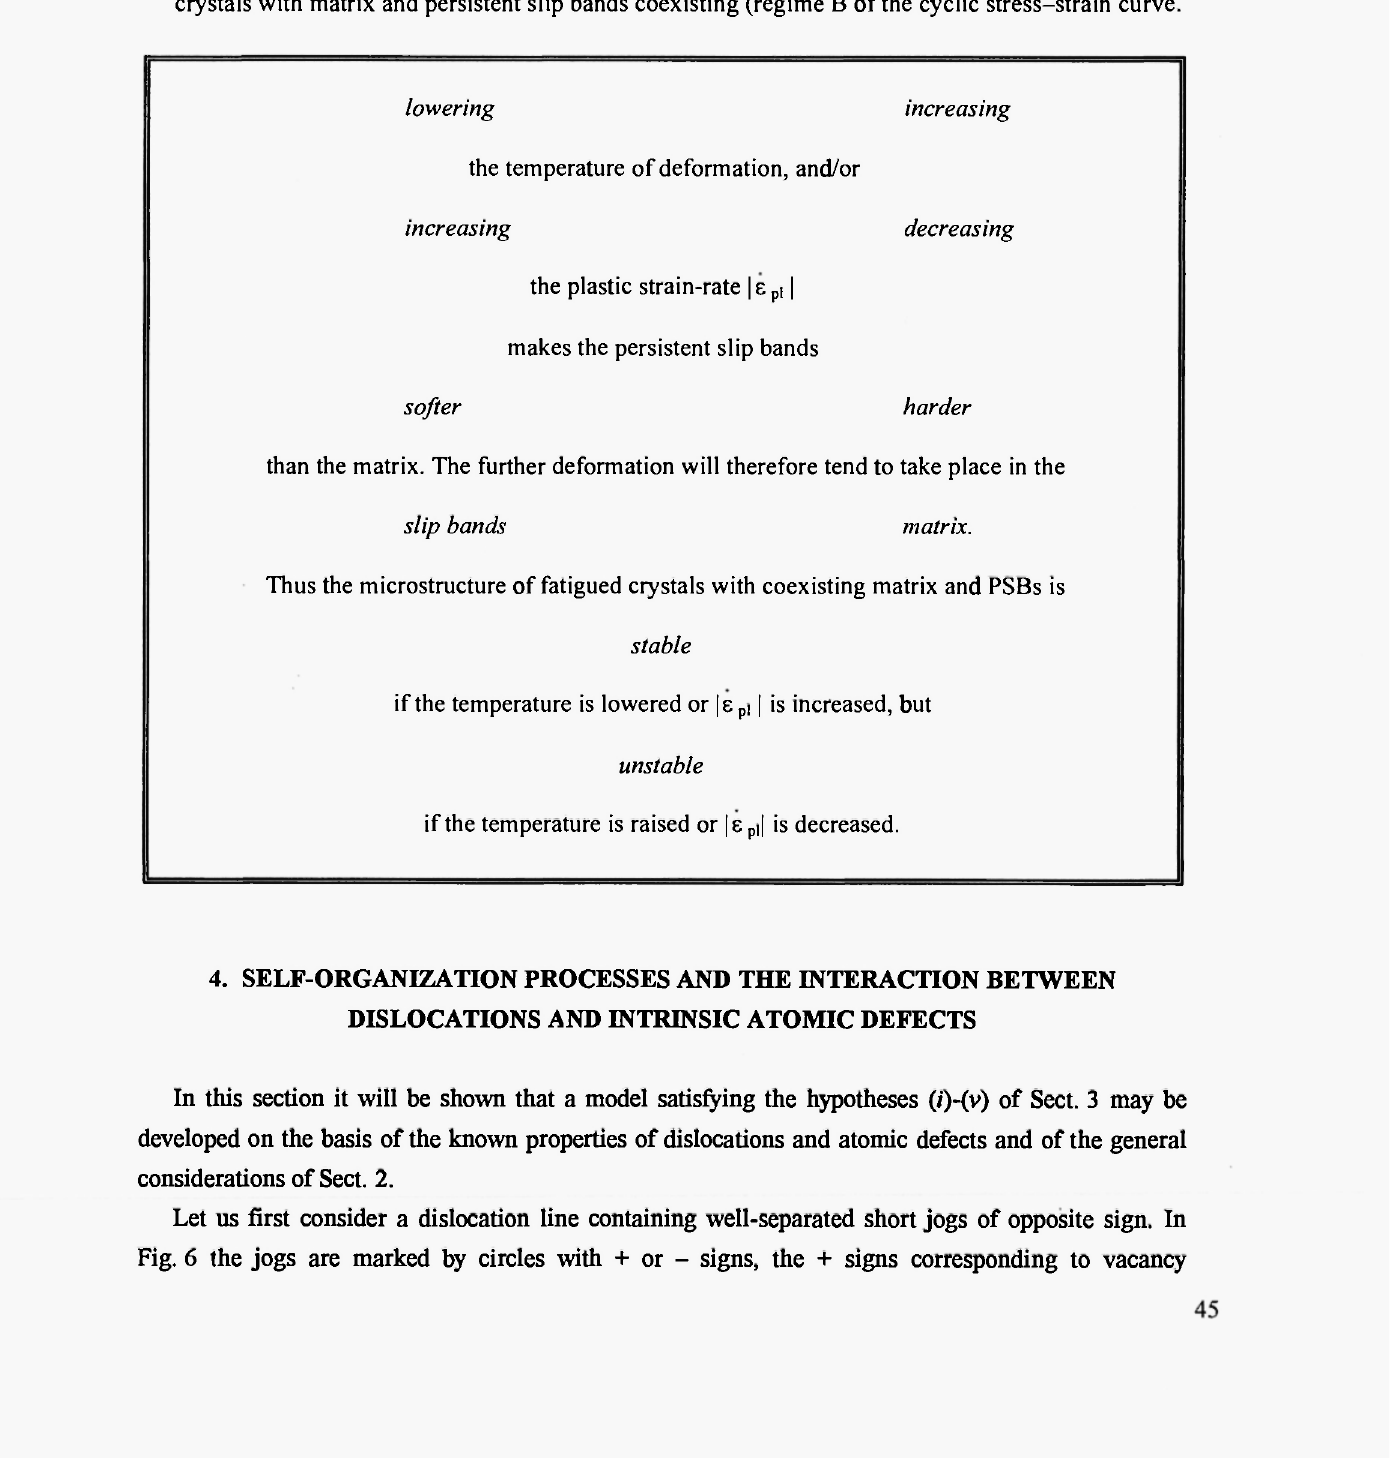
Effects of changes of temperature or plastic strain-rate on the microstructure of cyclically deformed crystals with matrix and persistent slip bands coexisting (regime Β of the cyclic stress-strain